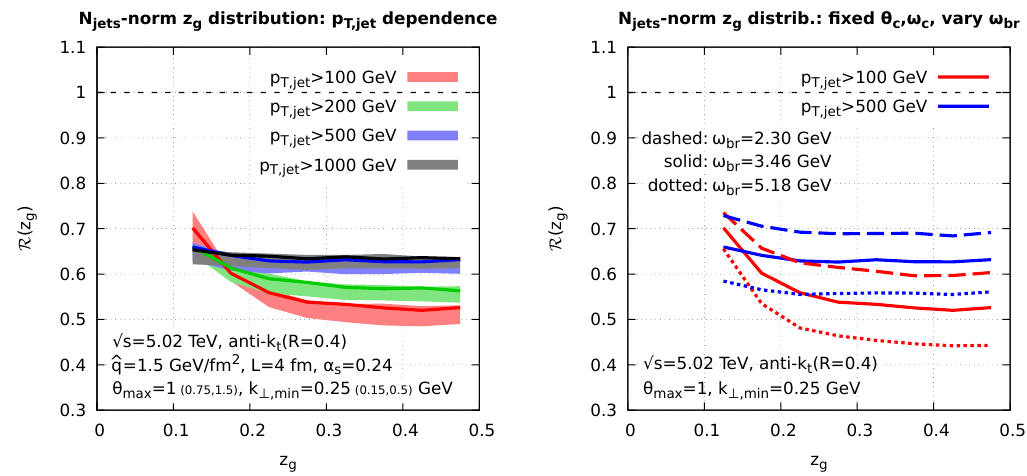
Figure 18 . Our full MC predictions for the medium/vacuum ratio R ( z g ) of the N jets -normalised z g distributions, including the convolution with the initial jet spectrum. Left: the sensitivity of our results to changes in the kinematic cuts (cid:18) max and k ? ; min . Right: the e(cid:11)ect of varying ! br (by